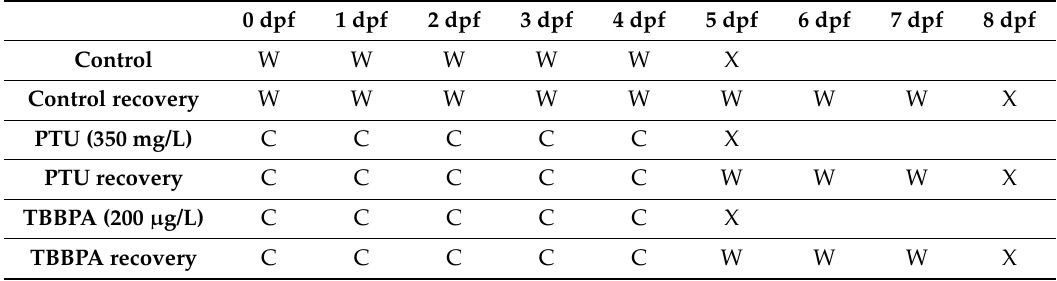
Table 1. Test set-up for THDC exposure with subsequent recovery